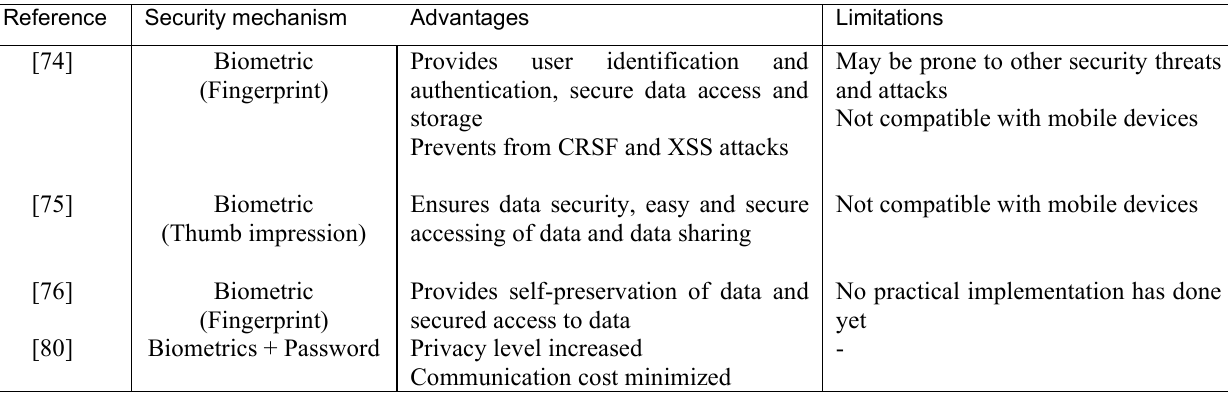
Table (4.c). The advantages and limitations of the biometric-based security